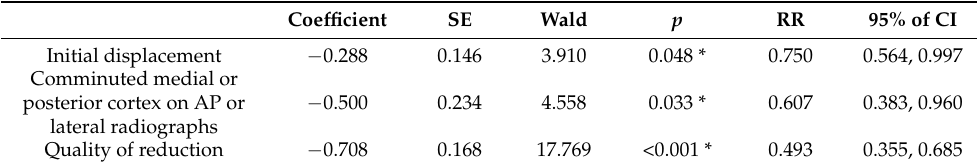
Table 2. Risk factors for achieving fracture union by Cox regression analysis. Coefficient SE Wald p